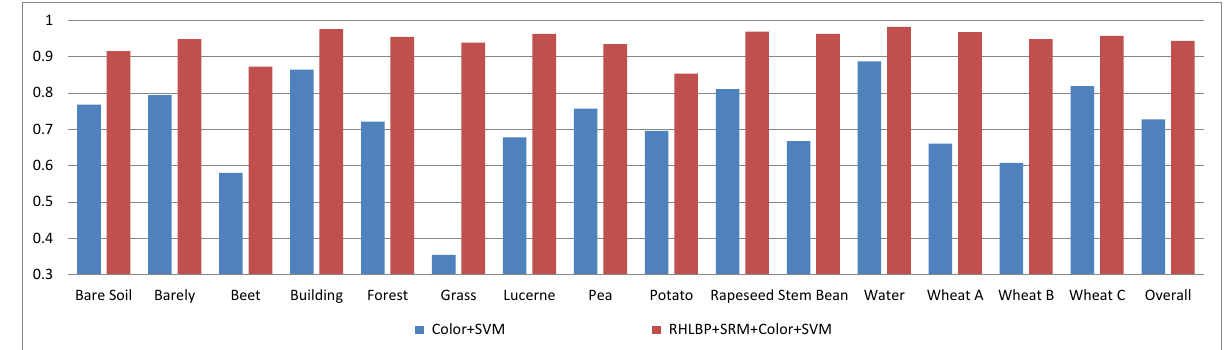
Figure 18. The classification accuracies of the color features introduced SVM algorithm and the method we proposed.